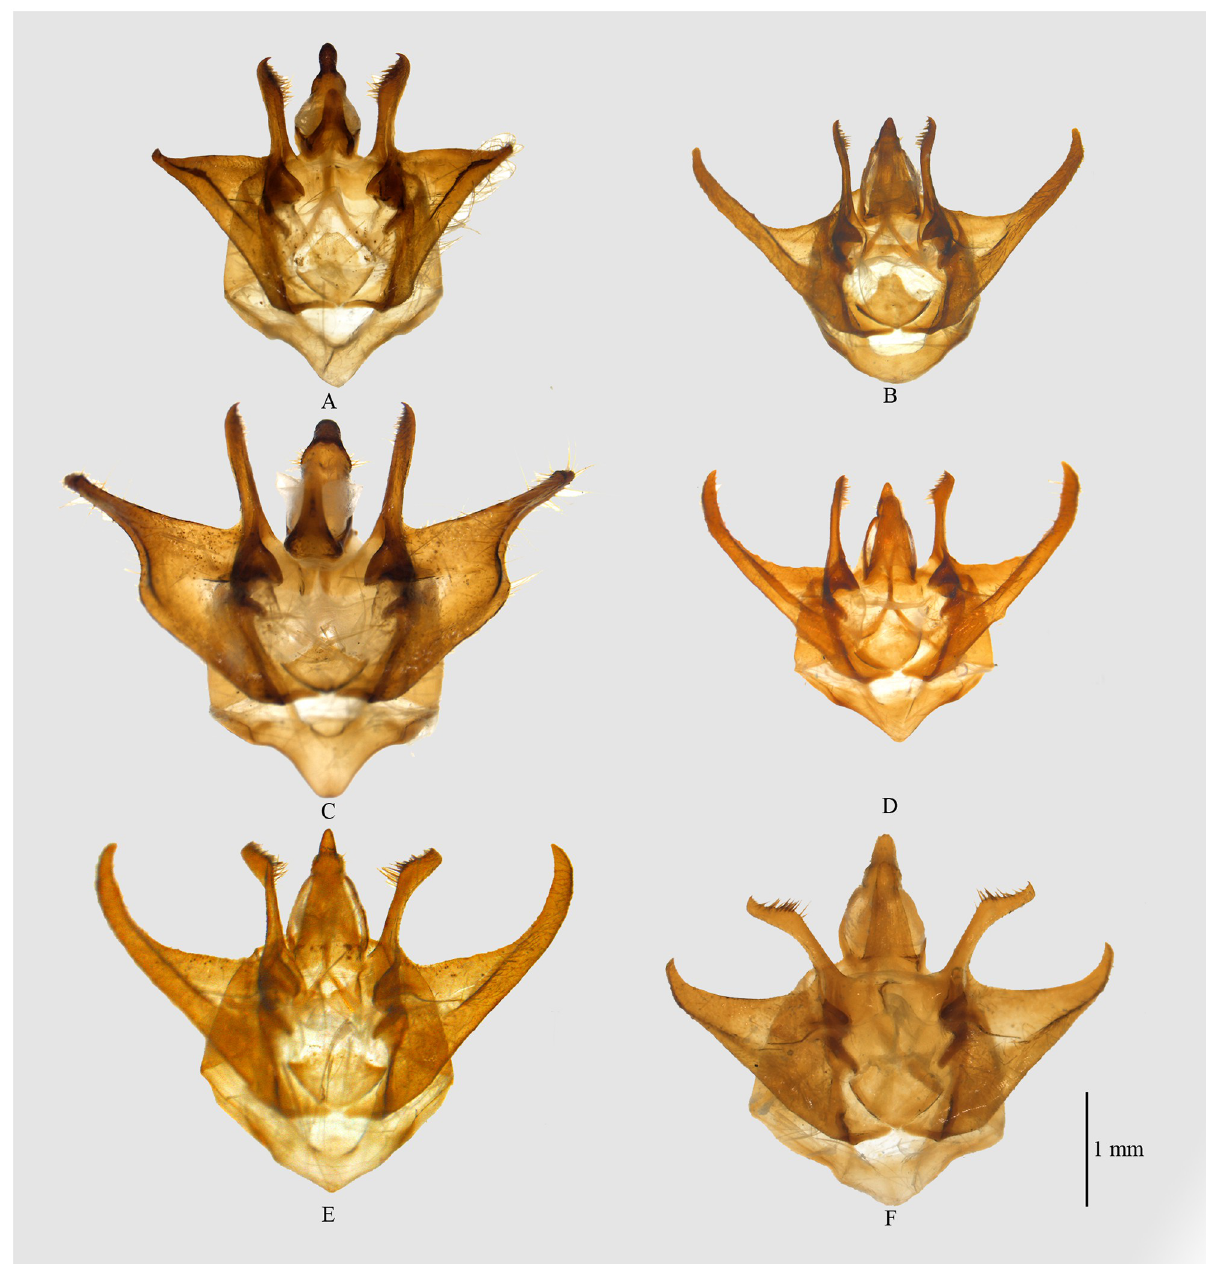
Fig 4. Male genitalia of Psyra . A. P . gracilis B. P . angulifera C. P . cuneata D. P . szetschwana E. P . fulvaria F. P . similaria . sclerotized, basally broad; Aedeagus long, stout, straight with ridges of scobination; vesica with three bundles of dense spines and an apical, long, pointed cornutus. Papilla analis round; apophyses anterior shorter than apophyses posterior; antrum broad, strongly sclerotized; ductus bursae narrow, wrinkled and highly sclerotized, forming an invagi- nation at middle; corpus bursae large, elliptical, bearing signum which consists of multiple short marginal spines and very narrow central space with few small spines.